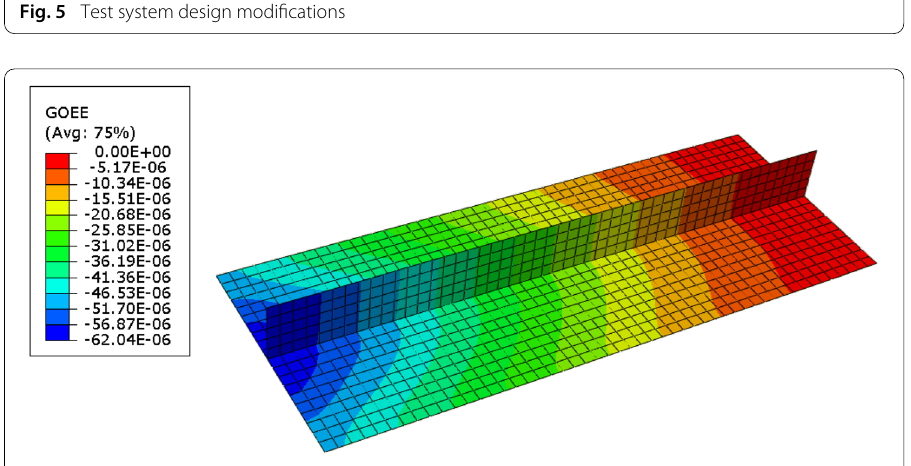
Fig. 5 Test system design modifications